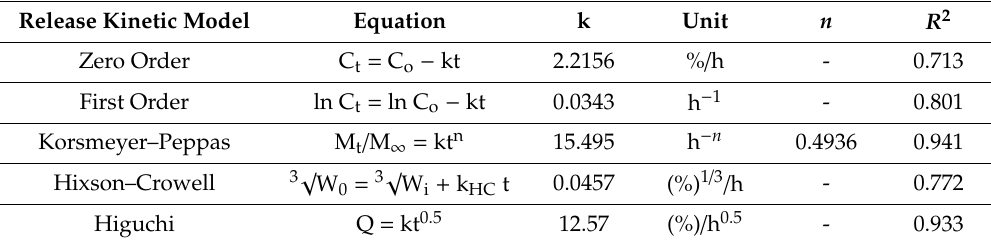
Table 5. Mechanism of PTX release from the optimal PTX-PLGA-NPs formulation.